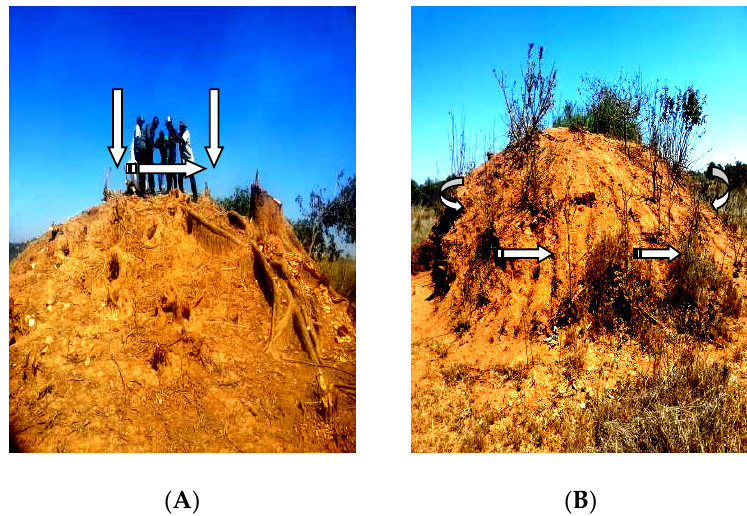
Figure 2. Photographs of termite mound soil sampling points: ( A ) Soil collection from the top of the termite mound; ( B ) soil collection along the base of the termite mound.